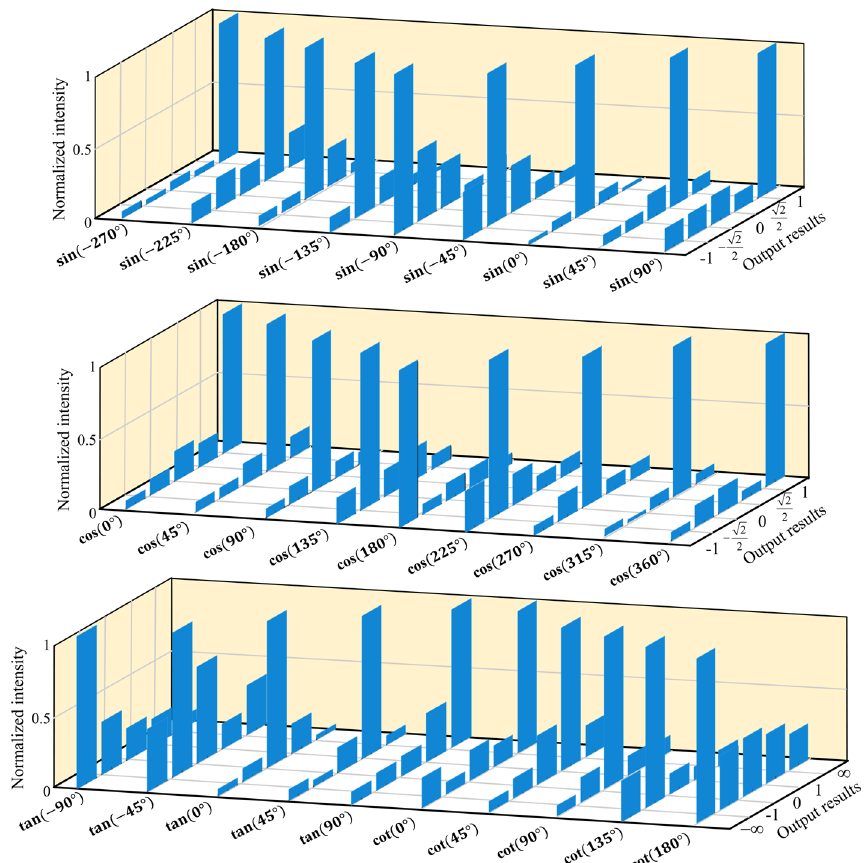
Fig. 6 The measured output results of all the trigonometric operations, which are demonstrated in the form of